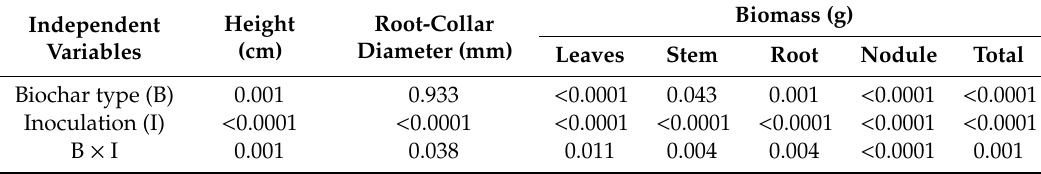
Table 2. p -Values for final black locust seedling morphological characteristics.